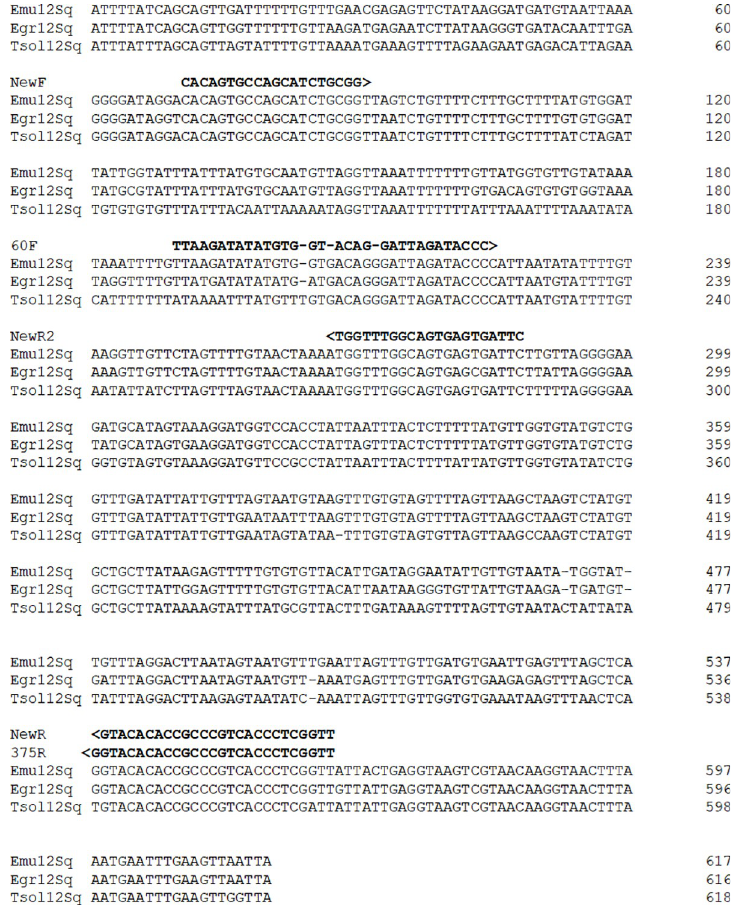
Fig 1. DNA sequence comparison of taeniid cestode 12 rDNA regions. Displayed is a CLUSTALW alignment of 12 S rDNA sequences deriving from E . multilocularis (Emu12Sq; GenBank accession no. AB018440.2), E . granulosus (Egr12Sq; NC_044548.1), and Taenia solium (Tsol12Sq; AB086256.1). Dashes have been included to maximize the alignment. DNA sequences of primers NewF and 60F used in this study are shown above the alignment in 5‘-3‘- orientation. The sequences of primers NewR and 375R are displayed in reverse